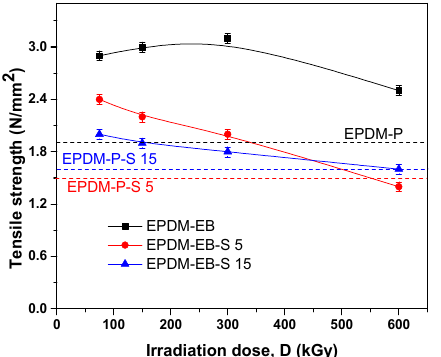
Figure 2. The influence of sawdust amount and cross-linking method (P/EB) on composites elasticity. Figure3. Theinfluenceofsawdustamountandcross-linkingmethod(P / Figure 3. The influence of sawdust amount and cross-linking method (P/EB) on composites’ tensile strength.